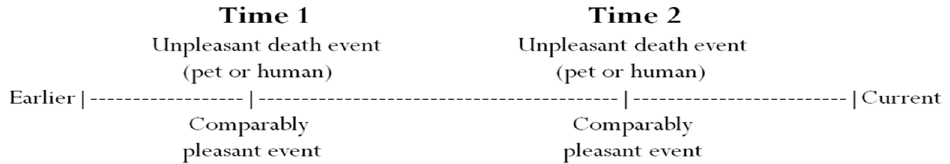
Figure 3. Events timeline for the unpleasant death events of a pet or human and matching comparably pleasant events both at Time 1 and Time 2.